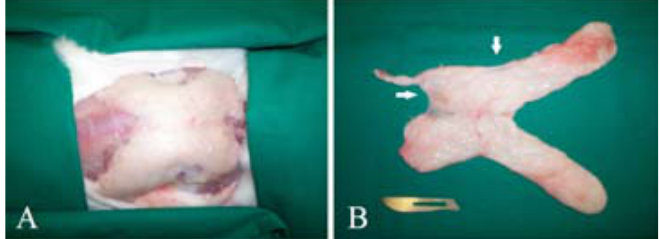
FIGURE 2 – Resection of the donor site. A . Anatomic delimitation of adipose tissue. B . The control side (proximal) and the experiment side (distal). Decrease in adipose tissue (arrow).